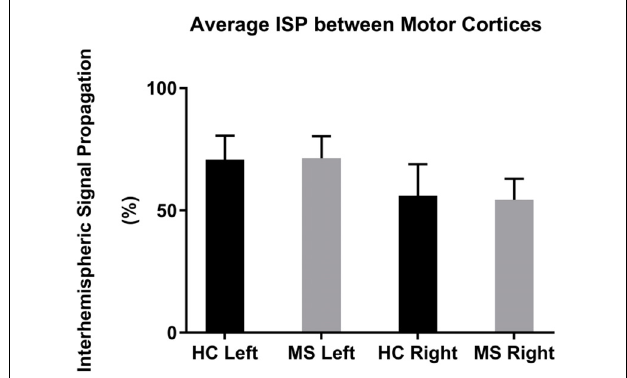
FIGURE 3 | Mean ISPs in healthy controls (HC) and MS patients for left and right motor cortex stimulation. Error bars represent 1 SEM.